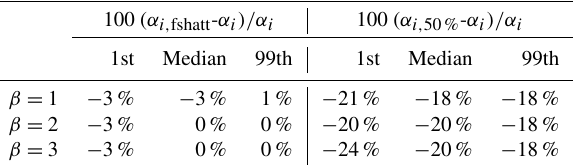
Table 2. Relative errors of retrieved prefactor α i, fshatt and α i, 50% with respect to α i in % for β = [1, 2,